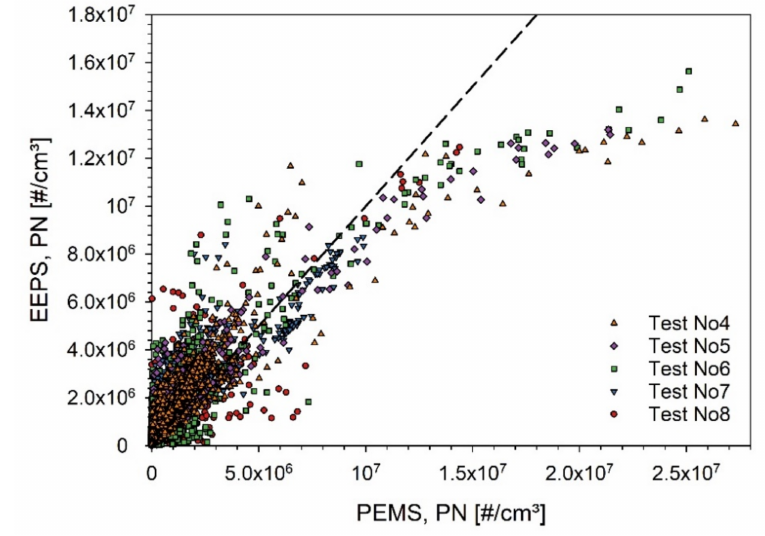
Figure 10. Correlation between the particle counter of the portable emissions measurement system (PEMS) and the engine exhaust particle sizer (EEPS) with a similar cut-off diameter of 23 nm.